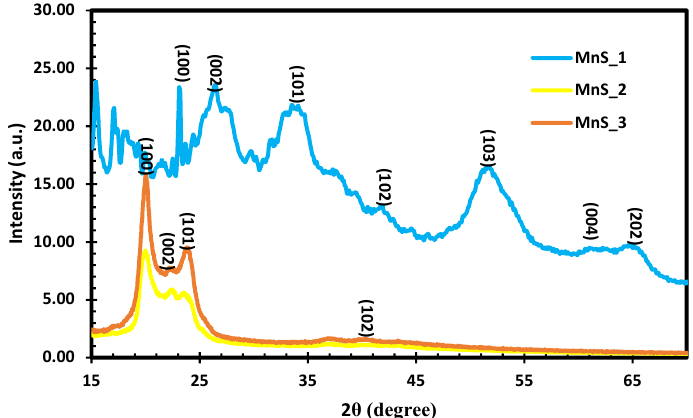
Figure 2. XRD of MnS_1, MnS_2 and MnS_3 nanoparticles.